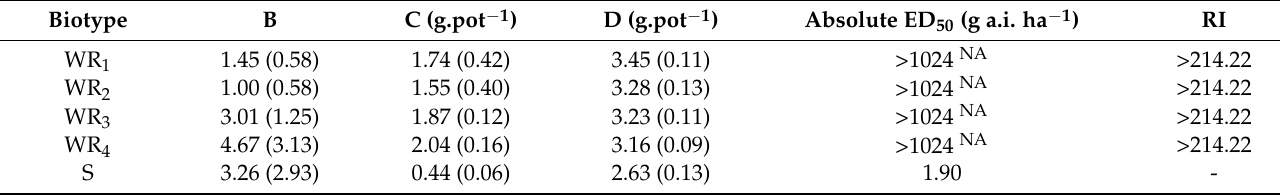
B: The relative slope around the parameter e, C is the lower limit, D is the upper limit, ED 50 (absolute): Estimated by function (ED (type="absolute")) in the drc package of R software. RI = absolute ED 50 Resistant population/absolute ED 50 Susceptible population). NA Not possible to estimate the ED 50 as plant fresh weight reduction was lower than 50% for all applied